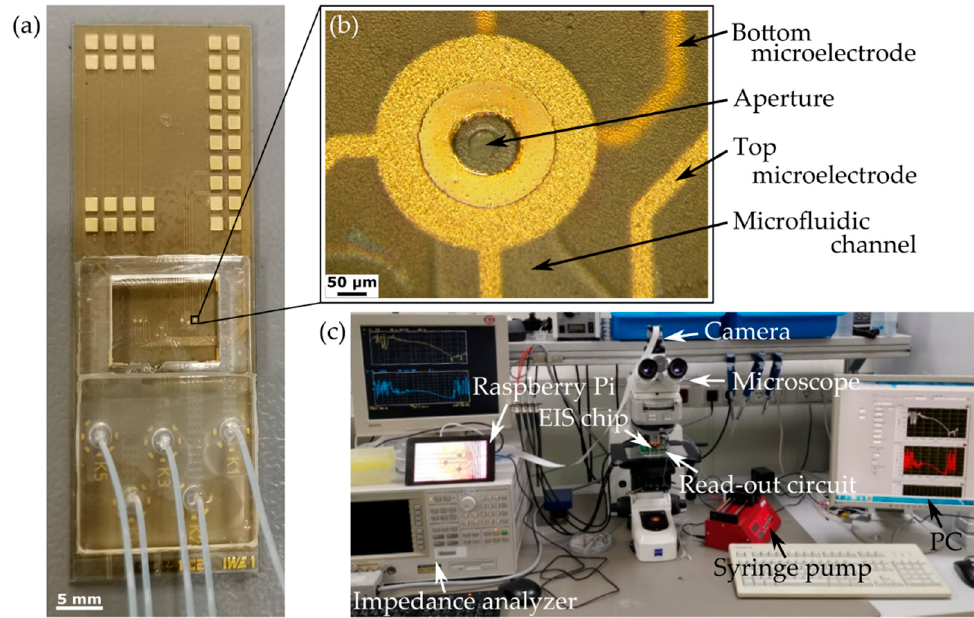
Figure 4. Photos of measurement setup. ( a ) Top view of fabricated microfluidic chip: upper part: contact pads, middle part: chamber with EIS measurement units, lower part: interposer of PDMS with Teflon tubes. ( b ) Top view of an EIS measurement unit with ring-shaped microelectrode and central aperture with a diameter of around 51 µm. ( c ) The complete measurement setup.